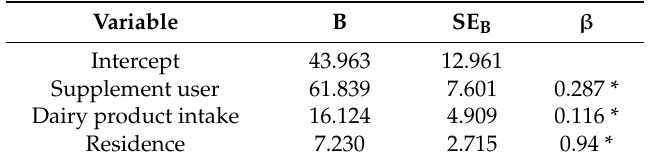
Table 4. Predictors of urinary iodine concentration (UIC) in pregnant women with UIC (µg/L) as dependent